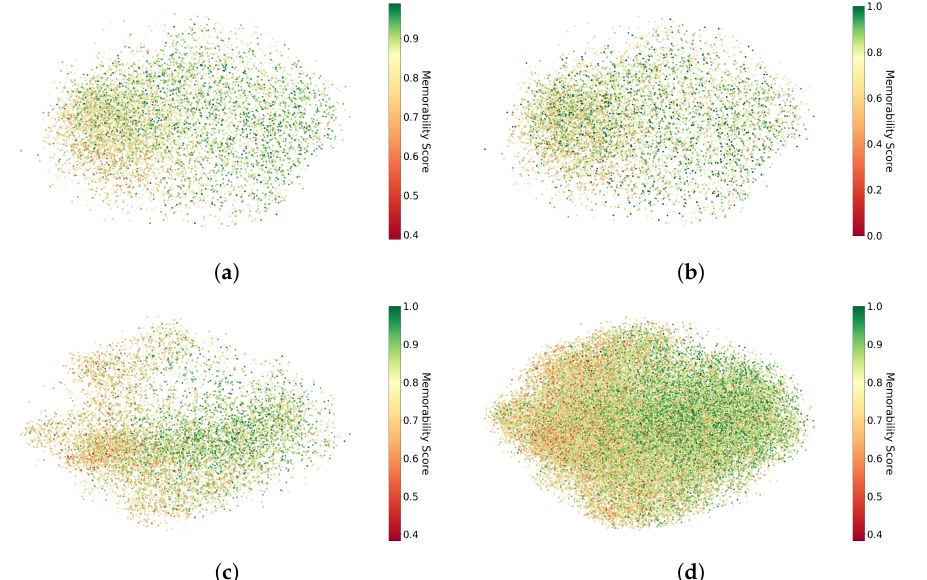
Figure 7. 2-dimensional PCA projection of SBERT embeddings by their memorability score. ( a ) VideoMem (short-term). ( b ) VideoMem (long-term). ( c ) Memento10K (early AVG). ( d ) Me- mento10K (late